Question: Write a single sentence explaining what this figure depicts.
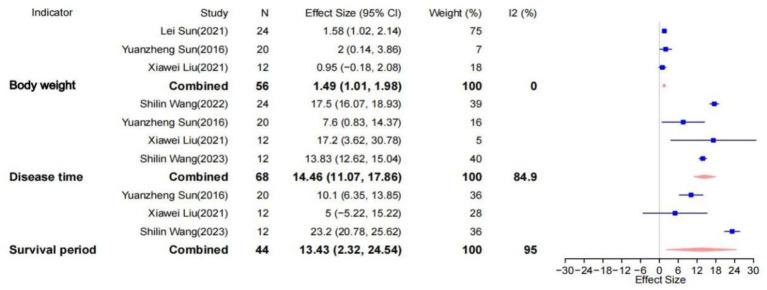
Answer: General conditions forest plot.